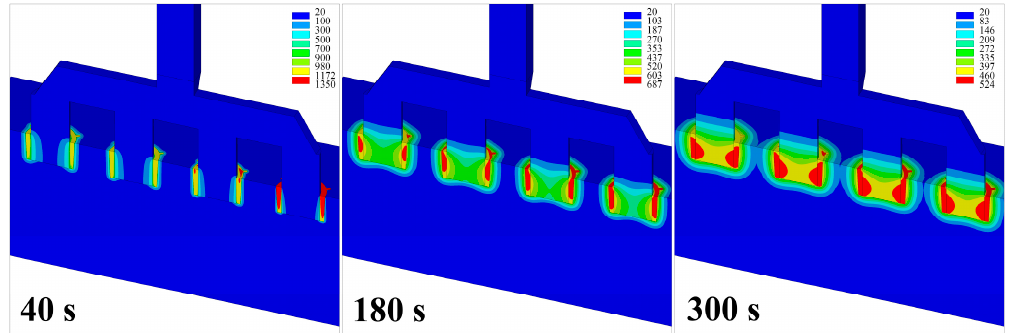
Figure 10. The temperature (°C) contour at 40 s, 180 s, and 300 s.